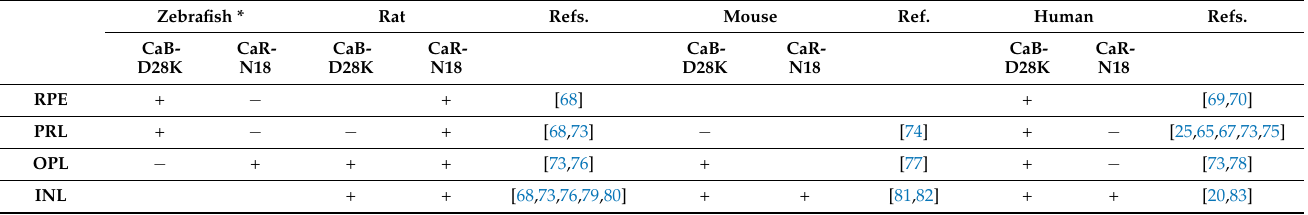
Table 1. Comparison of different species CaB-D28K/CaR-N18 localization in the retina layers. Zebrafish * Rat Refs. Mouse Ref. Human